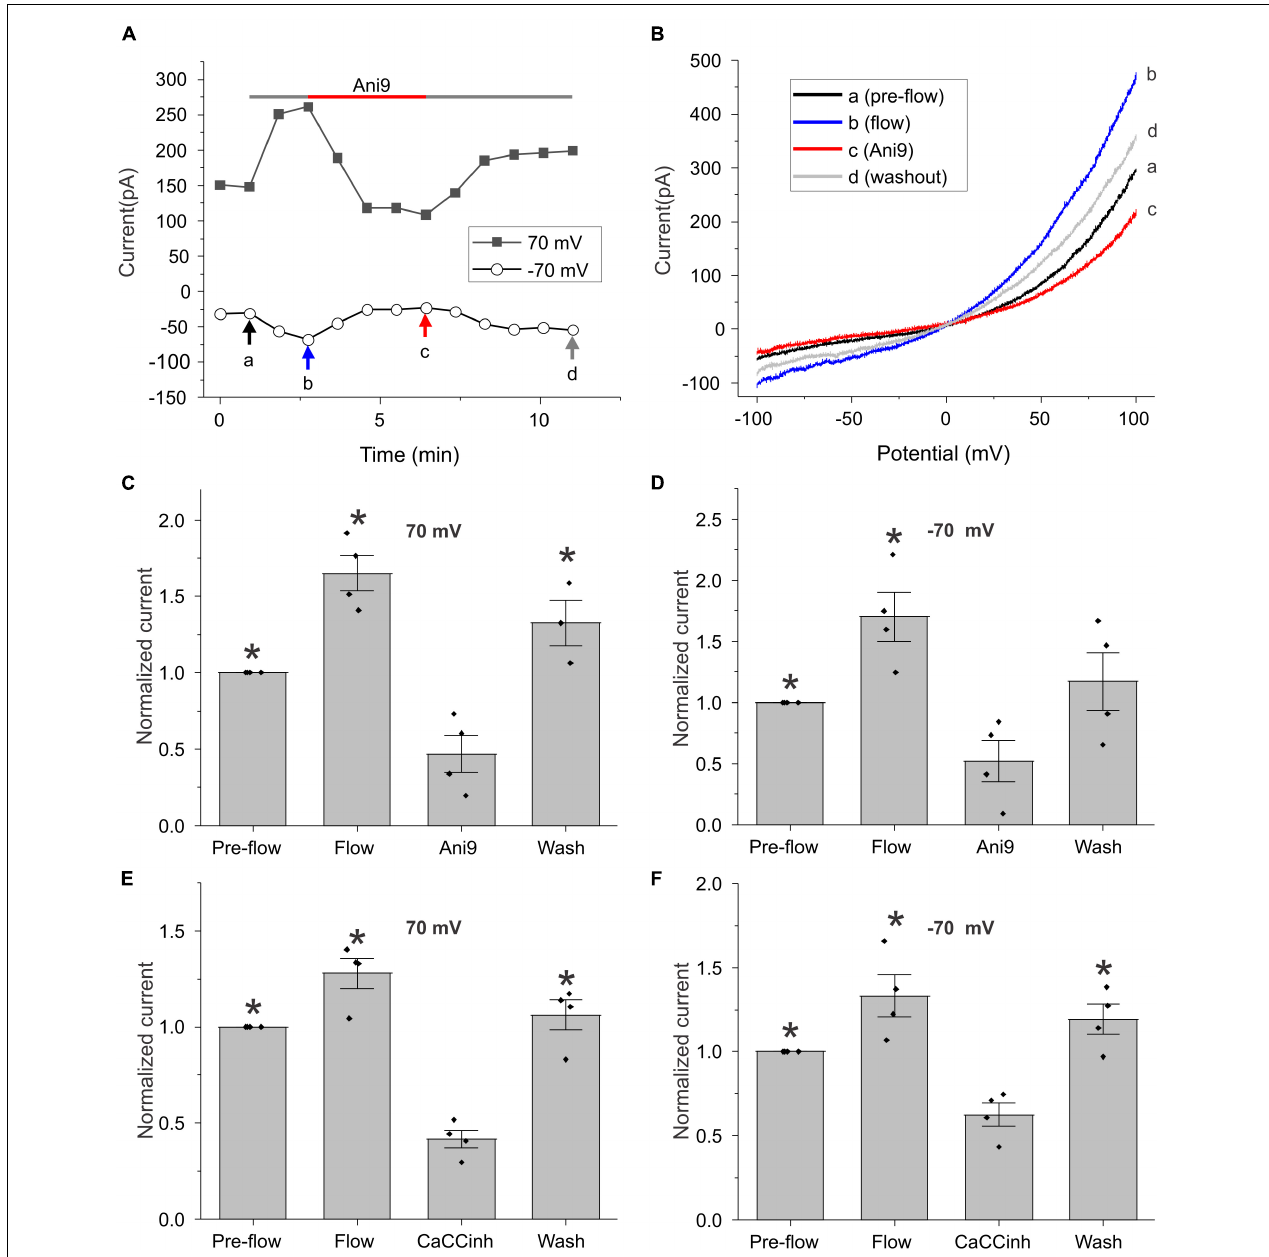
FIGURE 2 | Effect of chloride channel blockers on the flow-induced current. (A) Representative experiment showing that fluid flow invoked an increase in current at ± 70 mV (measured during ± 100 mV voltage-clamp ramps) that could be blocked by 5 µ M Ani9. Holding potential was –60 mV. Ramps from –100 to + 100 mV with a duration of 2 s were applied every 55 s. (B) Currents in response to ramps at points indicated by a, b, c, and d are shown in panel (A) . Bar graphs show the mean and standard error of the mean (SEM) ( n = 4) for Ani9 and CaCCinh treatments. (C,D) The effect of 5 µ M Ani9 on the amplitude of the flow-induced current at ± 70 mV normalized with respect to the value of the current at ± 70 mV pre-flow. Significant differences (*) are relative to Ani9 condition ( n = 4). (E,F) The effect of 50 µ M CaCCinh on the amplitude of the flow-induced current at ± 70 mV normalized with respect to the value of the current at ± 70 mV pre-flow. Significant differences (*) are relative to the CaCCinh condition ( n = 4). In all cases, the bath solution consisted of standard NaCl external solution. Pipette solution consisted of CsCl internal solution containing 600 nM [Ca 2 + ] i .